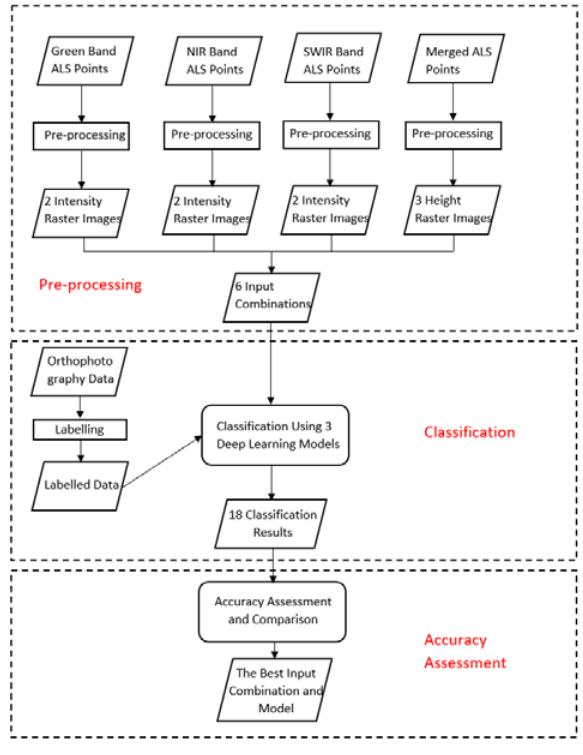
Figure 3. Workflow of the propose